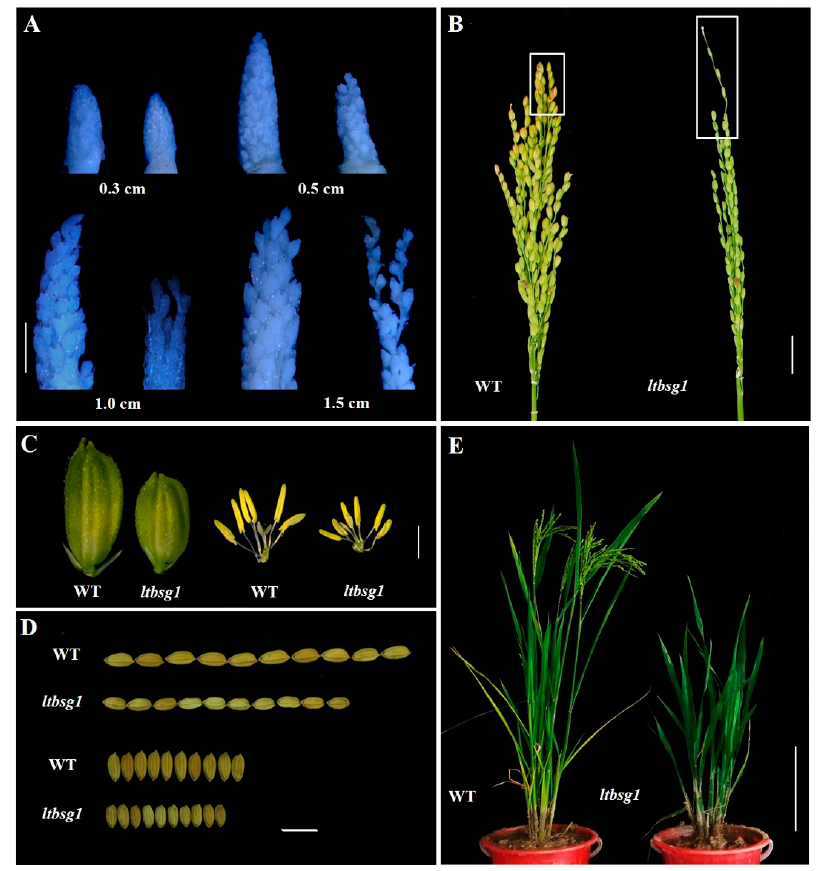
Figure 1. Phenotype characterization of wild type (WT) and mutant ltbsg1 (longer top branch and shorter grain 1) . ( A ) The young panicles of different length in WT and mutant ltbsg1 . Bar = 2 mm. Left: WT; Right: ltbsg1 ; ( B ) The panicles of WT and mutant ltbsg1 at grain-filling stage. The white box indicated the top branch of panicle. Bar = 2 cm; ( C ) The spikelets and flowers of WT and mutant ltbsg1 . Bar = 2 mm; ( D ) The grains length and width of WT and mutant ltbsg1 . Bar = 1 cm; ( E ) Plants of WT and mutant ltbsg1 at grain-filling stage. Bar = 20 cm.